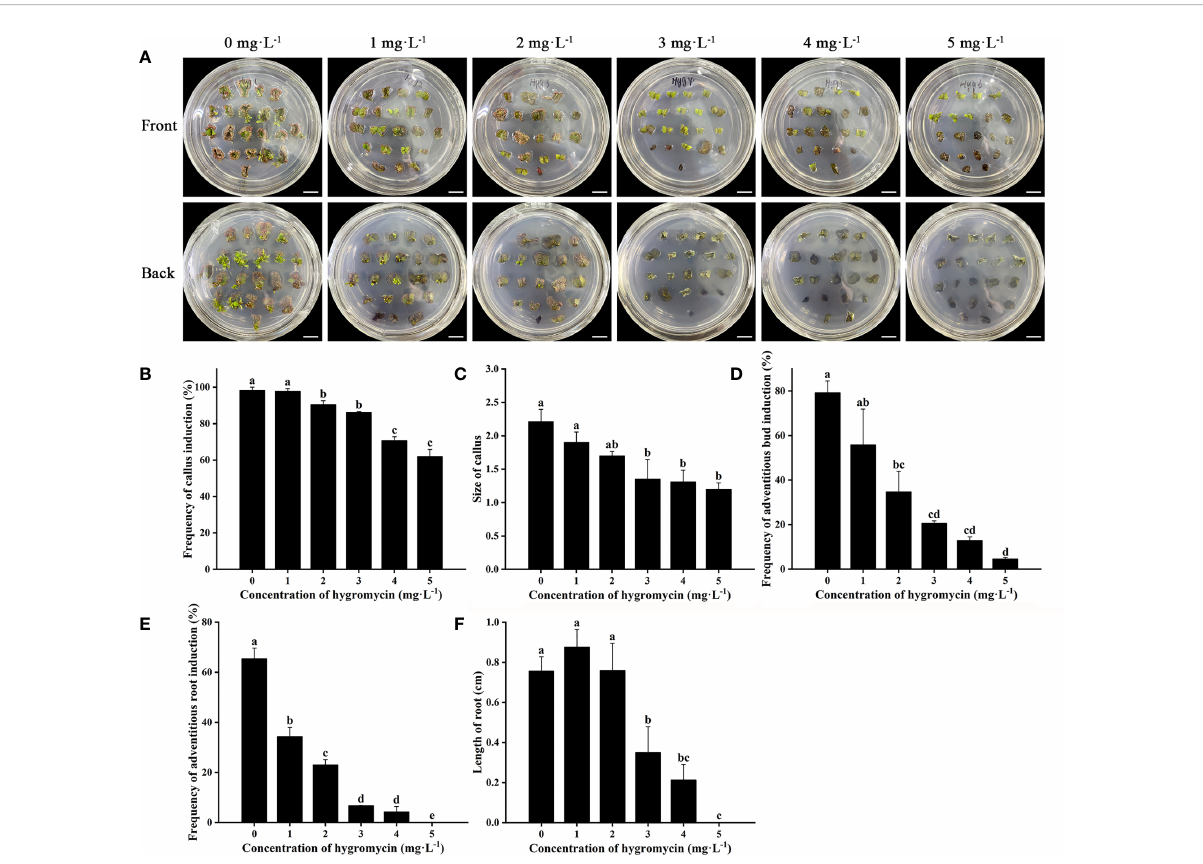
FIGURE 5 Effects of hygromycin on regeneration of E. urophylla × E. grandis DH32-29. (A) Explants are induced to regenerate adventitious buds on medium supplemented with 0, 1, 2, 3, 4, and 5 mg·L − 1 hygromycin. Effects of hygromycin on (B) the frequency of callus induction, (C) callus size, (D) the frequency of adventitious bud induction, (E) the frequency of adventitious root induction, and (F) the length of root. Scale bar: 1 cm. Different letters indicate signi fi cant differences among treatments using Duncan ’ s multiple range test at p <